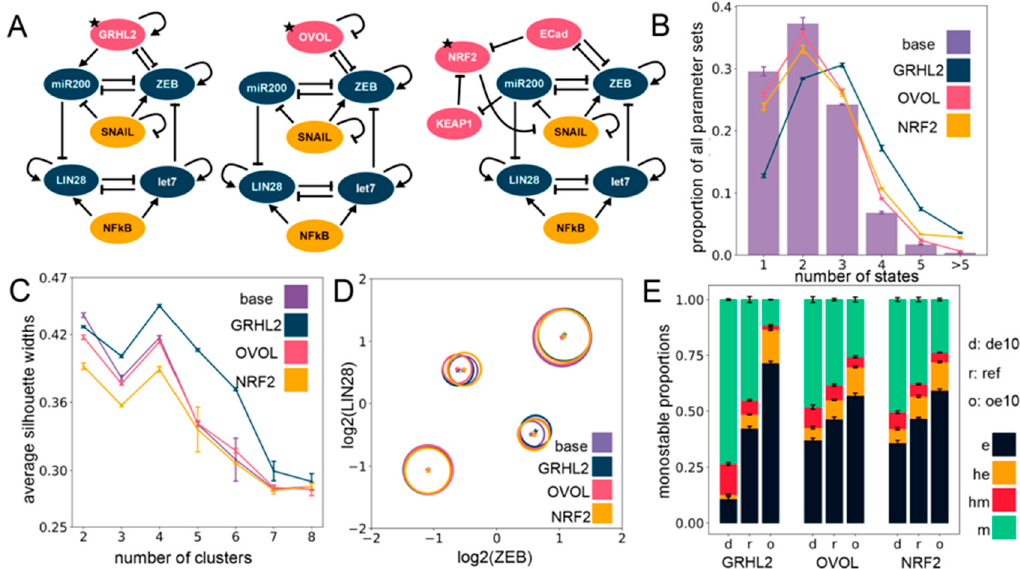
Figure 3. Including phenotypic stability factors (PSFs) preserves the cluster structure seen for the EMP–stemness circuit. ( A ) Different PSFs (GRHL2, OVOL2, NRF2) added to the base (control) EMP–stemness circuit. All new nodes are shown in pink; the PSF node added is marked with a star. ( B ) Multistability profiles for all the PSF circuits compared to the base circuit. ( C ) The average silhouette widths at different numbers of clusters for all PSF circuits with the cluster membership assignment via a K-means algorithm. Note the distinct peak at four clusters across all circuits. ( D ) Cluster centers in the ZEB–LIN28 plane (EMP–stemness plane) for a single RACIPE replicate of each of the circuits show that the cluster centers are well preserved across the circuits. Gene-wise normalization is performed independently for all circuits (see Supplementary Section S1.2.3). ( E ) Phenotypic distributions for all monostable solutions upon over-expressing and down-expressing the different PSF nodes. (de10: 10-fold down-expression, ref: Reference unperturbed circuit, oe10: 10-fold over-expression) (( B , C , E ): The values are averaged across n = 5 RACIPE replicates and the error bars represent the across-replicate standard deviations).